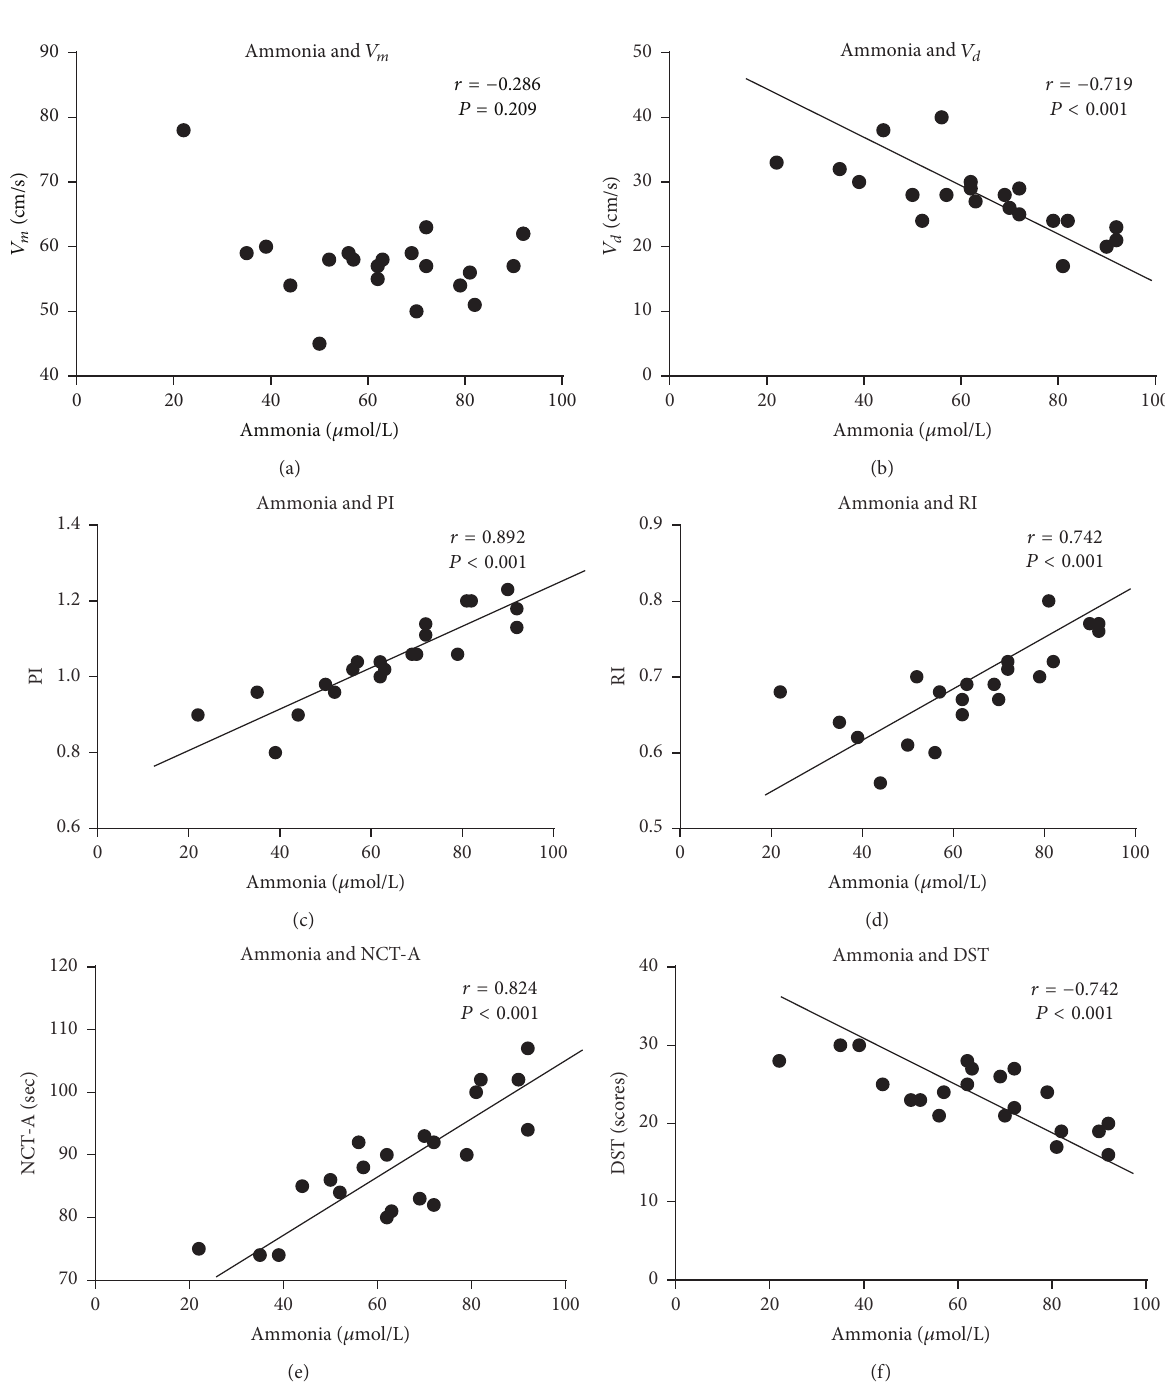
Figure 3: Correlation between ammonia and cerebral hemodynamics ( 𝑉 𝑚 , 𝑉 𝑑 , PI, and RI) and declining cognitive function (NCT-A and DST) in patients with MHE . It includes the subfigures (a, b, c, d, e, and f). Subfigure (a) is correlation between ammonia and 𝑉 𝑚 . Subfigure (b) is correlation between ammonia and 𝑉 𝑑 . Subfigure (c) is correlation between ammonia and PI. Subfigure (d) is correlation between ammonia and RI. Subfigure (e) is correlation between ammonia and NCT-A. Subfigure (f) is correlation between ammonia and DST. Correlation was analyzed by Pearson’s correlation coefficient. 𝑃 < 0.05 means significant differences in correlation between two